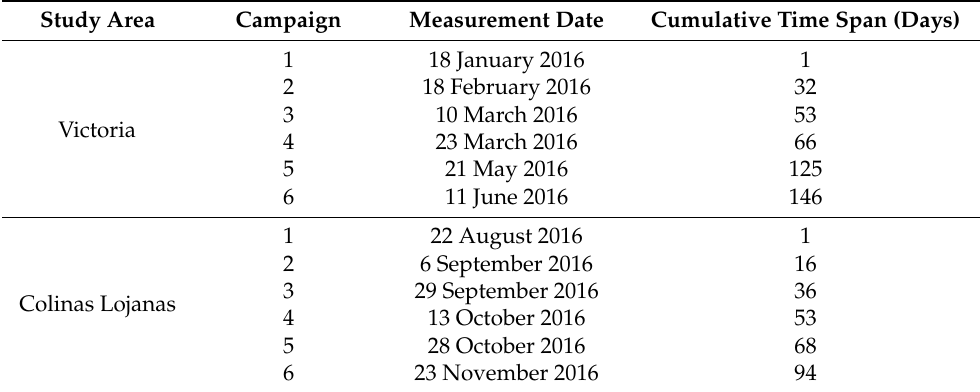
Table 1. Detail of the GNSS measurement campaigns performed in the study areas. The time spans refer to the cumulative time between measurement campaigns.